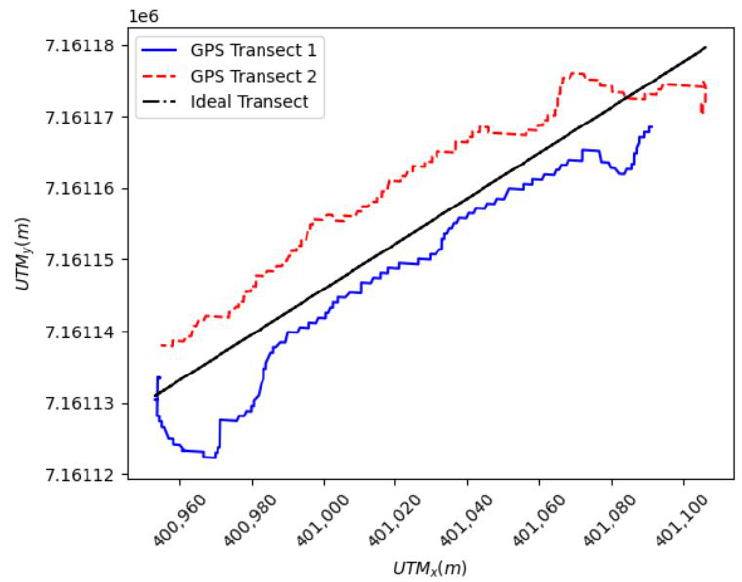
Figure 4. GPS coordinates of the boat tracks transects with the interpolated ideal linear